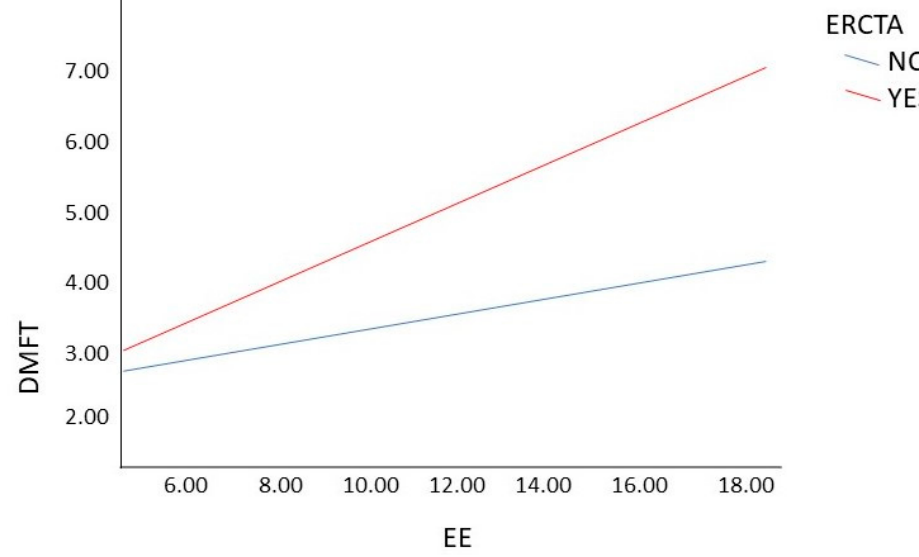
Figure 1. Moderation analysis of personality type A on emotional eating and DMFT. Note: DMFT = index to determine decayed, missing and filled teeth; ERCTA = core on type A personality scale; EE= emotional eating.